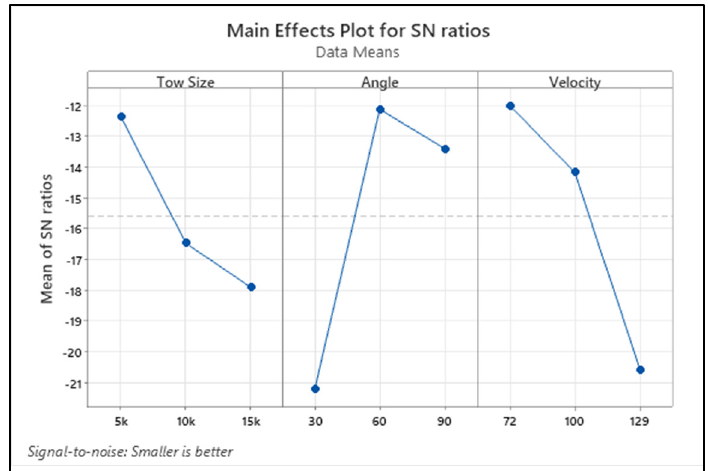
Figure 6. Main effect plot of S/N ratio for R a . Table 7. Response table for R a.